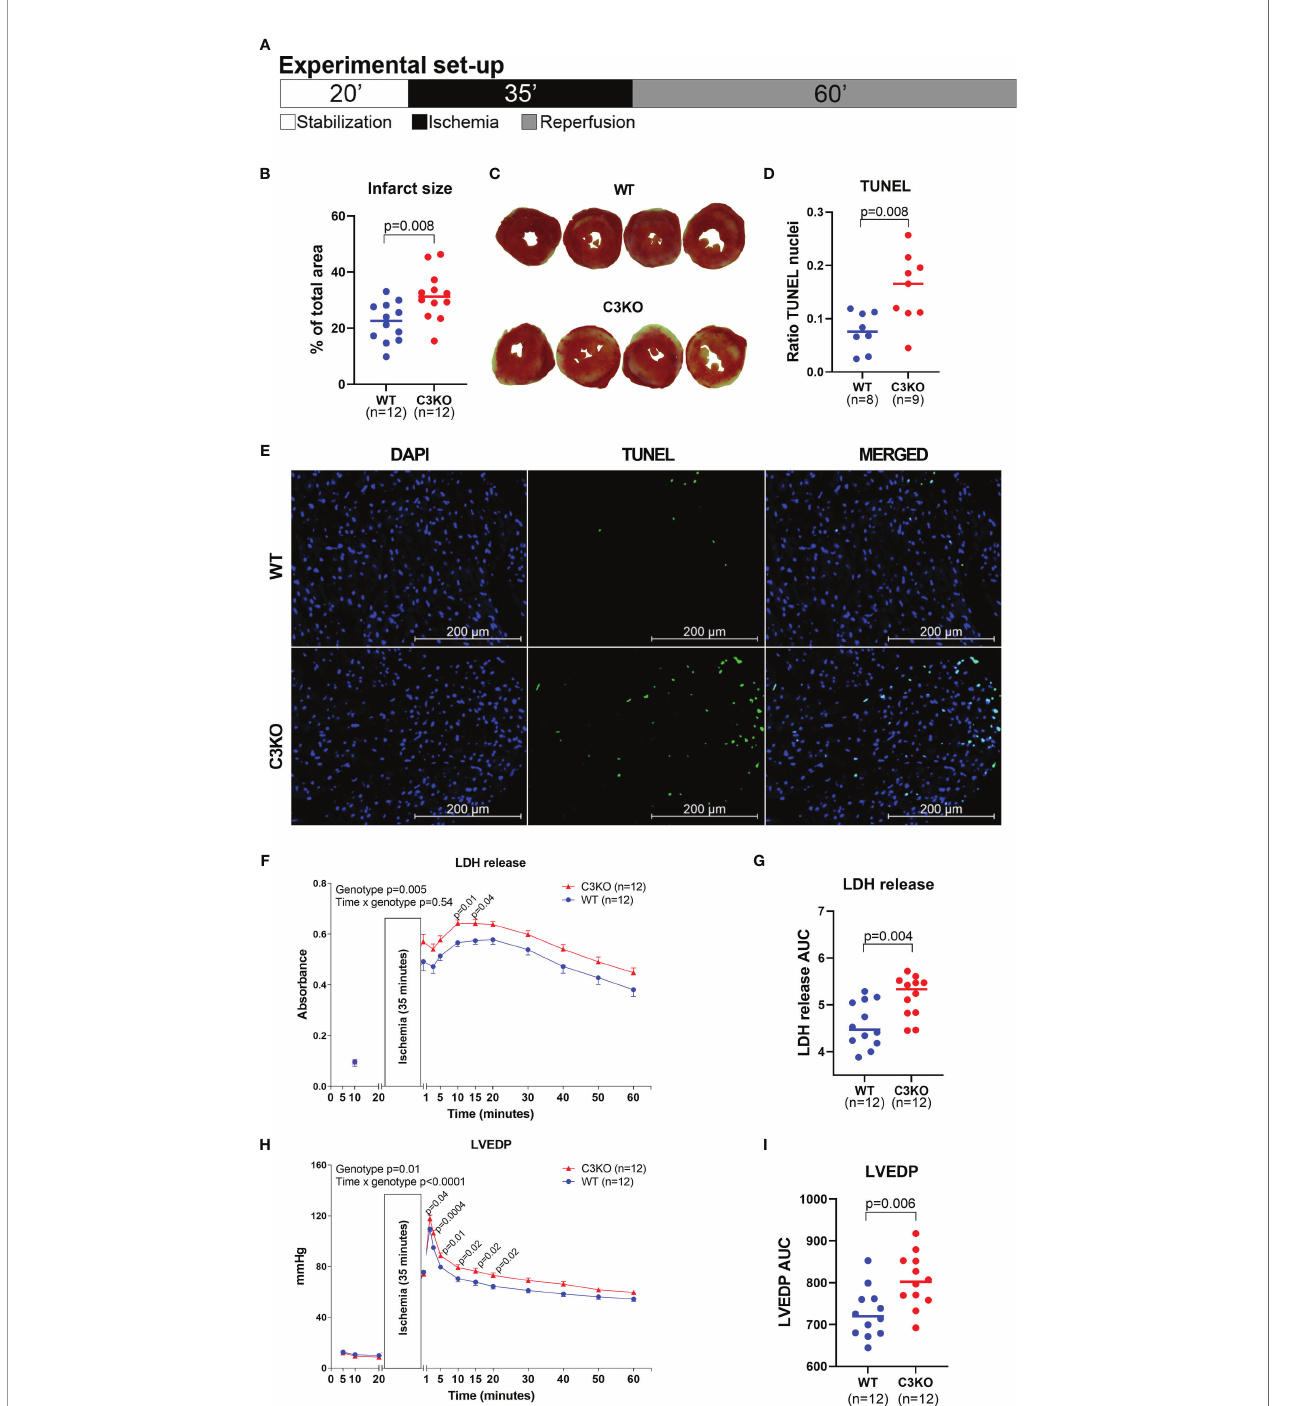
FIGURE 2 | Langendorff heart perfusion. Retrograde buffer perfusion of isolated wild type (WT) and complement component 3 knock out (C3KO) hearts exposed to ischemia-reperfusion. Hearts were exposed to 20 minutes stabilization, 35 minutes ischemia and 60 minutes of reperfusion as indicated in panel (A) . (B) Infarct size measurements after reperfusion with images of hearts representing the mean infarct size value in each genotype (C) . (D) Ratio of TUNEL stained nuclei over total number of nuclei in heart sections after ischemia-reperfusion, and (E) representative images of TUNEL and DAPI stained heart sections (20× magni fi cation, Scale bar: 200 µm). (F) Lactate dehydrogenase (LDH) release, corresponding to tissue damage, measured in coronary perfusate, also presented as area under curve (G) . (H) Left ventricular end-diastolic pressure (LVEDP) throughout the ischemia-reperfusion experiment, also as area under curve (I) . Data sets are displayed as scatterplots with median or mean ±